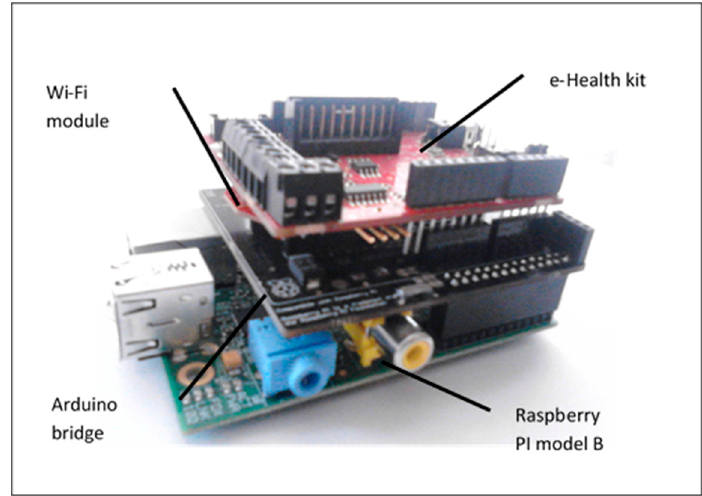
Figure 2. Stacking of the IoT SN modules.